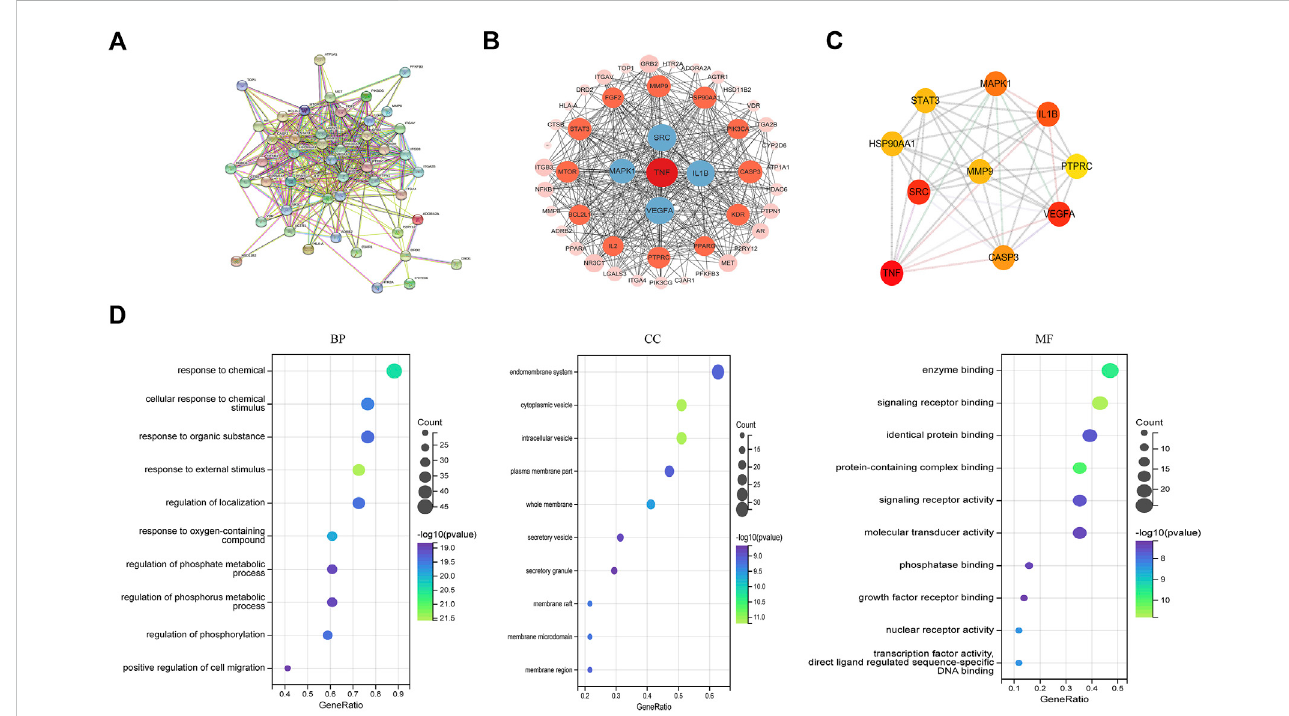
FIGURE 4 Screening for core targets and analysis of NGR1-SIC PPI protein interactions. (A, B) Network of NGR1-SIC related target PPI interaction. (C) Screening of the top ten core targets from a list of 59. (D) The 51 targets ’ GO enrichment analysis.